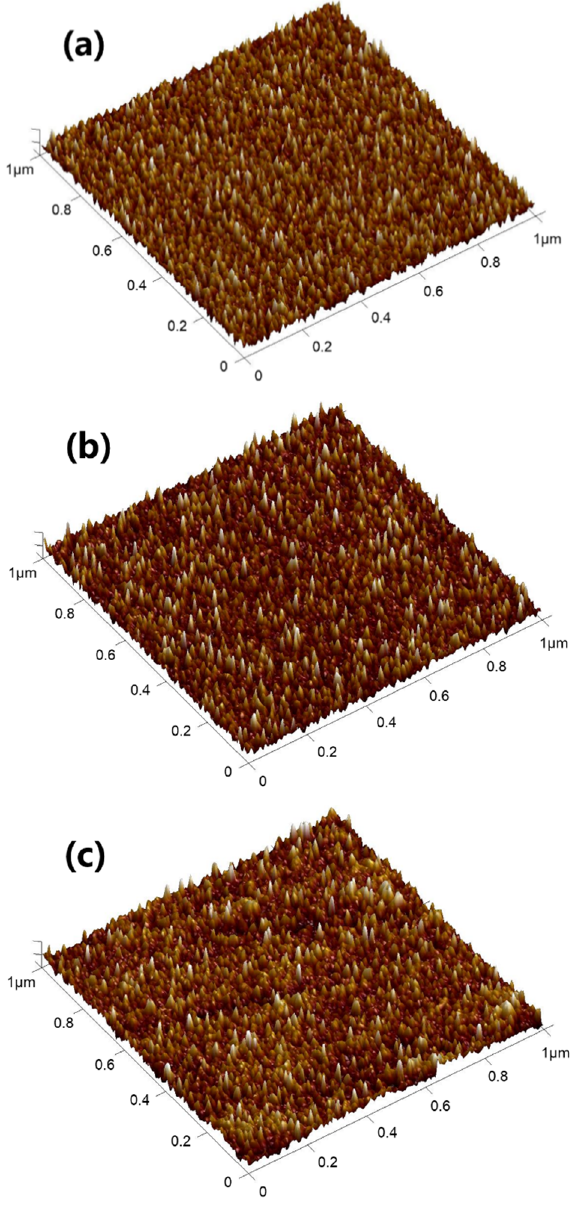
Figure 6. Atomic force microscopy (AFM) images (1 μm × 1 μm square scan) of ( a ) V 2 O 5 /Al 2 O 3 film; ( b ) V 2 O 5 /MgO film; ( c ) V 2 O 5 /SiO 2 film.